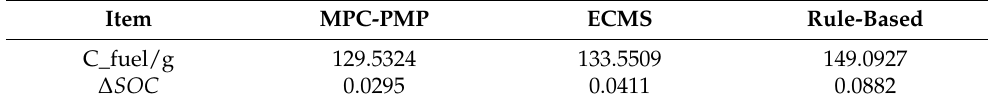
Table 5. Fuel consumption and SOC fluctuation of each algorithm.